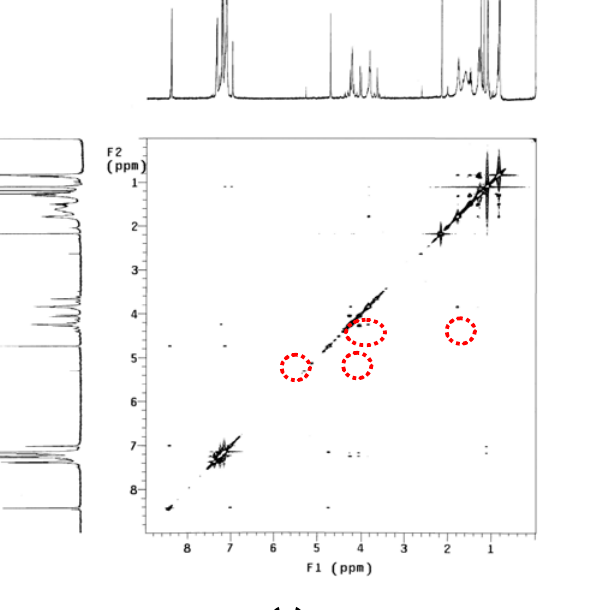
, 300K) T-ROESY map and ( b ) 3